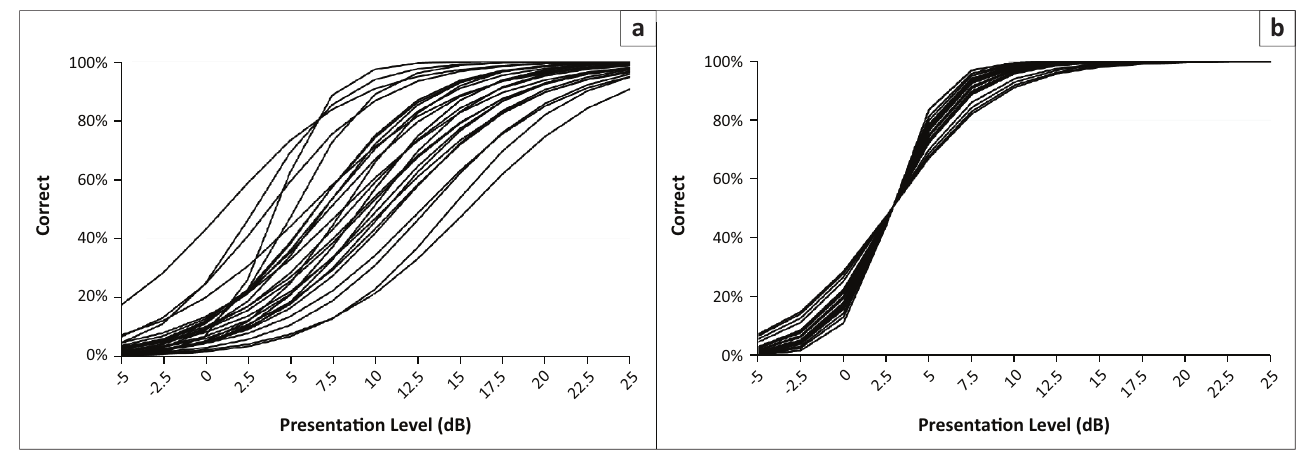
FIGURE 1: Psychometric functions for the 28 recorded isiZulu words unadjusted (a) and adjusted (b) for listener hearing thresholds.